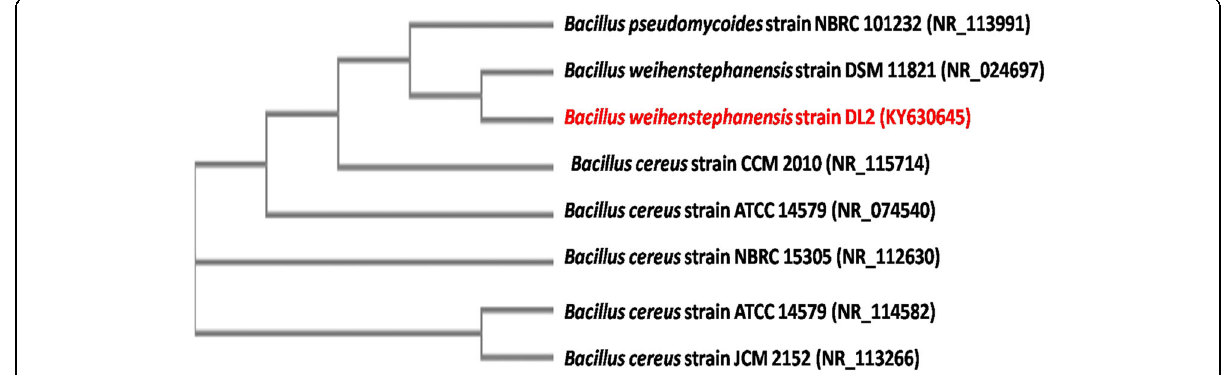
Fig. 2 Phylogenetic tree based on 16S rRNA gene sequences of DL2 bacterial strain and other Bacillus species on